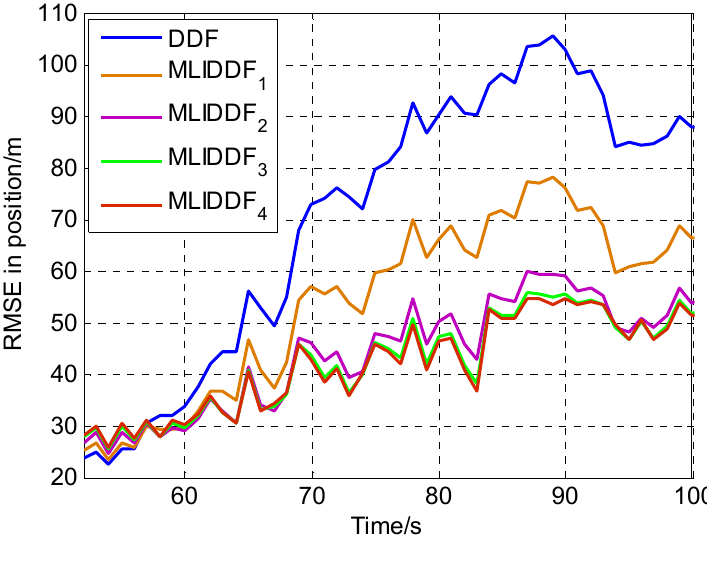
with 5, MLIDDF 2